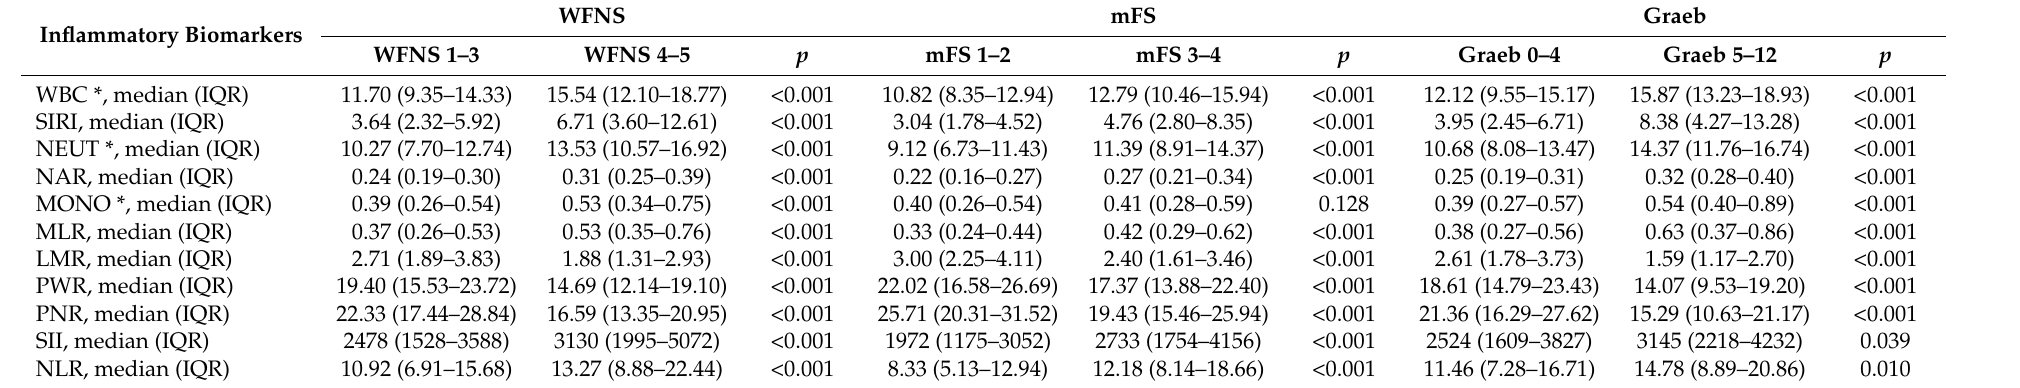
Table 5. Associations between inflammatory biomarkers and WFNS grade, mFS grade, and Graeb score on admission. Inflammatory